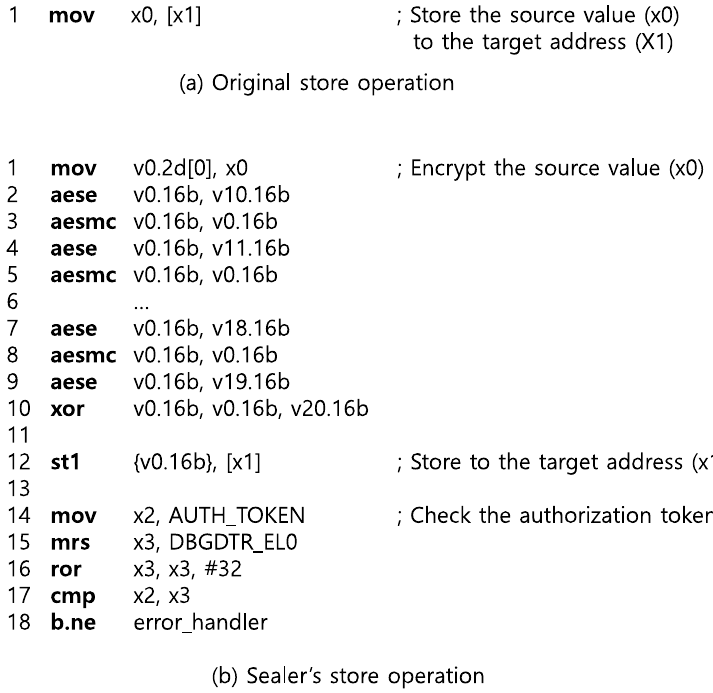
Figure 5. Store operation in Sealer.